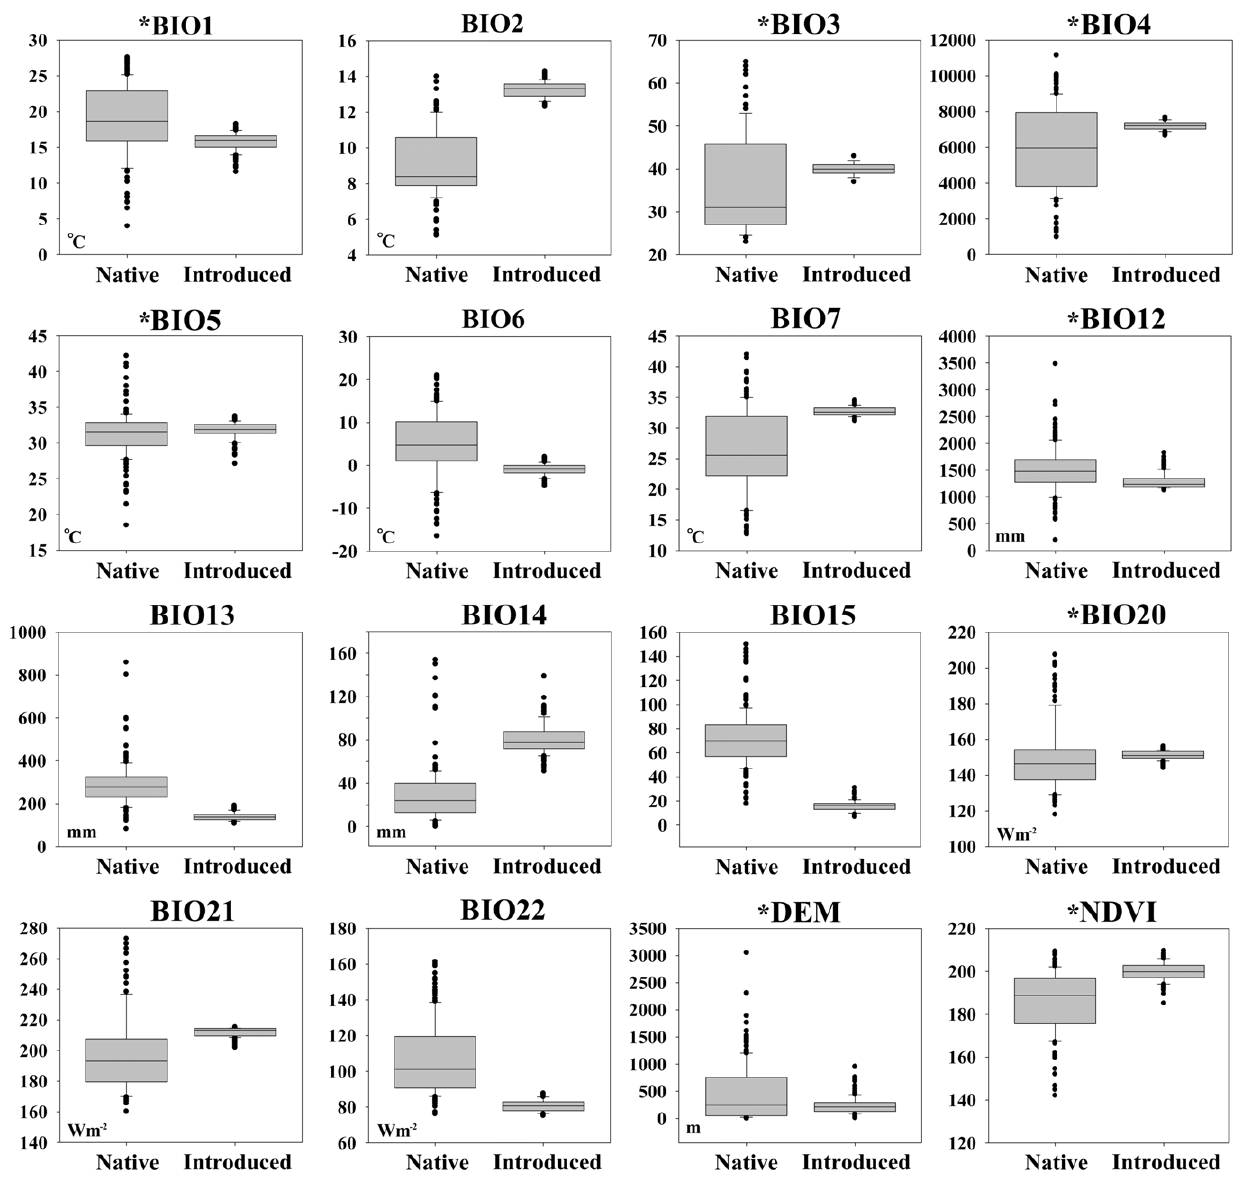
Figure 1. Direct comparison of Bean plataspid occurrence-associated variables between native and introduced distributional areas. The Dataset I (variables without asterisk) with columns (i.e., IQR) were not overlapped between the two areas representing variables of high discrepancy. The Dataset II (variables with asterisk) with columns were more or less overlapped representing variables of low discrepancy.